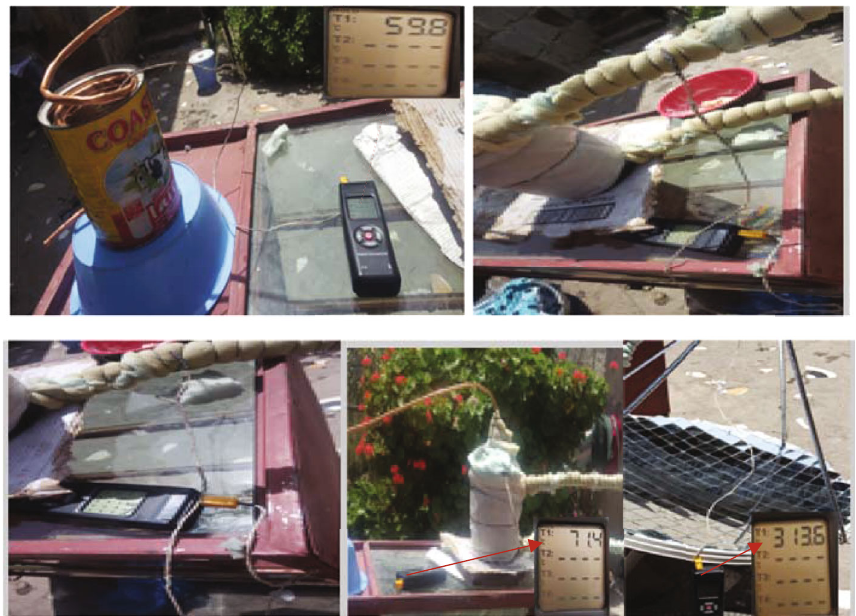
Figure 4: Installation position of the thermocouple.